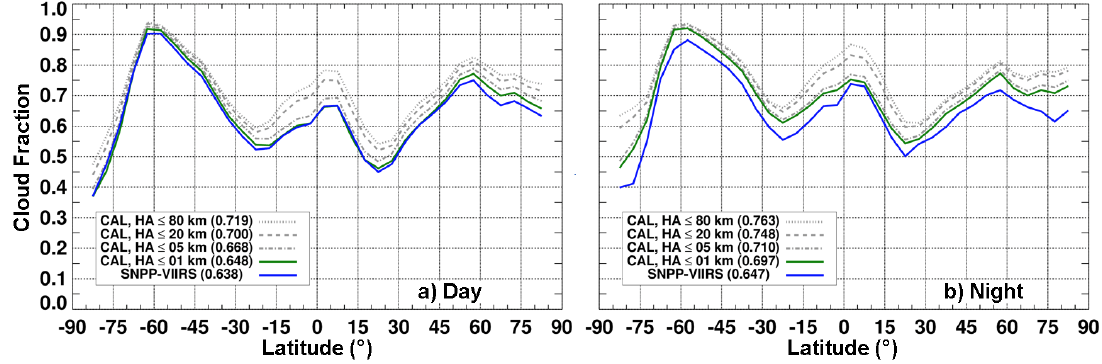
Figure 2. Mean zonal ( a ) day and ( b ) night cloud fractions from CV1S and CALIOP for four horizontal averaging scales, JAJO 2015–2016, using all matched data.